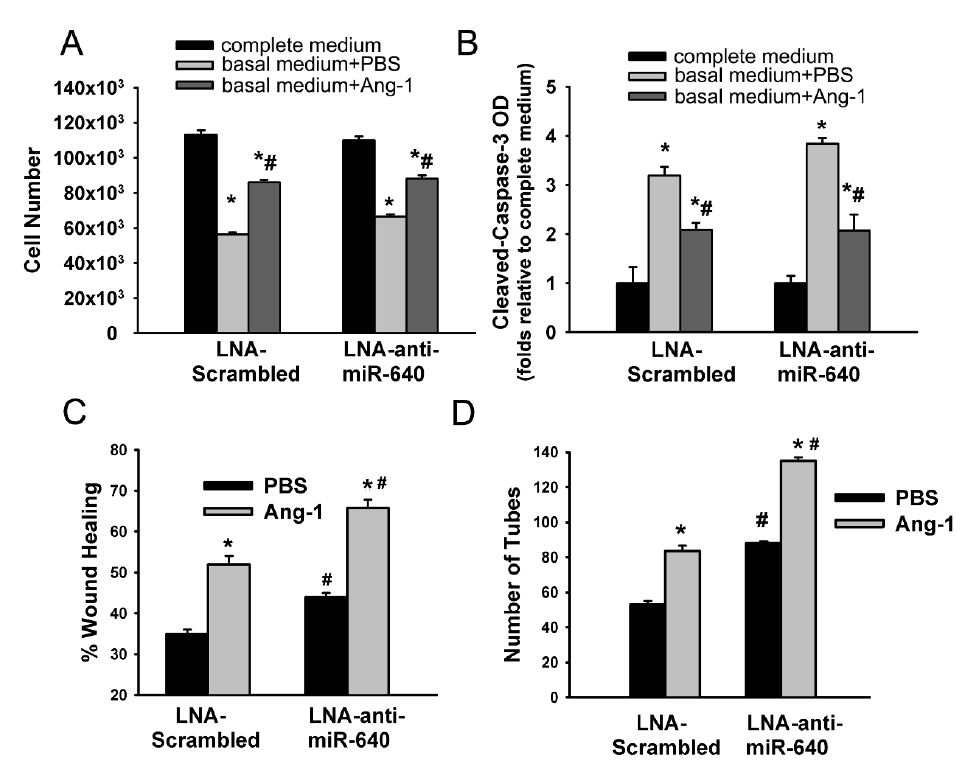
Figure 3. Effects of the miR-640 inhibitor on cell survival, migration, and differentiation. (A and B): HUVECs were transfected with control (LNA-scrambled) or miR-640 (LNA-anti-miR-640) inhibitors. Equal numbers of cells were cultured in complete, and basal medium containing PBS or Ang-1. Cell counts and cleaved caspase-3 optical densities (OD) were evaluated 24 h later. Values are means ± SEM. * p < 0.05, compared to cells maintained in complete medium. # p < 0.05, compared to PBS. ( C ): Scratch wound healing assays of HUVECs transfected with control or miR-640 inhibitors. Cells were maintained in basal medium containing PBS or Ang-1. Percentage wound healing was measured 8 h after wounding with a pipette tip. Values are means ± SEM. * p < 0.05, compared to PBS. # p < 0.05, compared to cells transfected with control inhibitor and treated with PBS or Ang-1. ( D ): Total tube numbers of growth factor-reduced Matrigel and basal medium containing PBS or Ang-1. Values are means ± SEM. with PBS or